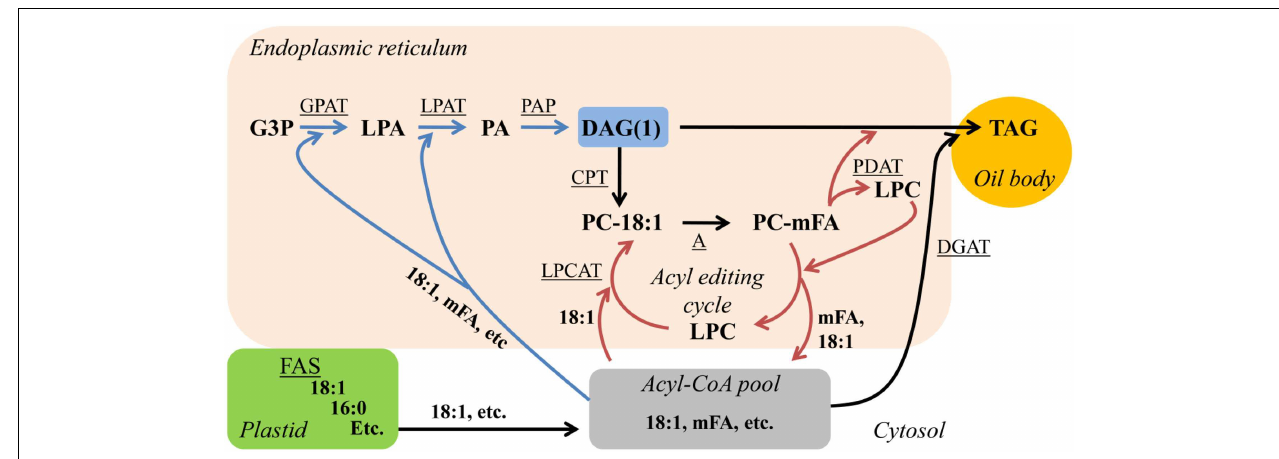
triacylglycerol. Enzymatic reactions are underlined: A, modification of FA esterified to PC; CPT, CDP-choline:DAG cholinephosphotransferase; DGAT, acyl-CoA:DAG acyltransferase; FAS, fatty acid synthesis; GPAT, acyl-CoA:G3P acyltransferase; LPAT, acyl-CoA:LPA acyltransferase; LPCAT, acyl-CoA:LPC acyltransferase; PAP, PA phosphatase; PDAT, phospholipid:DAG